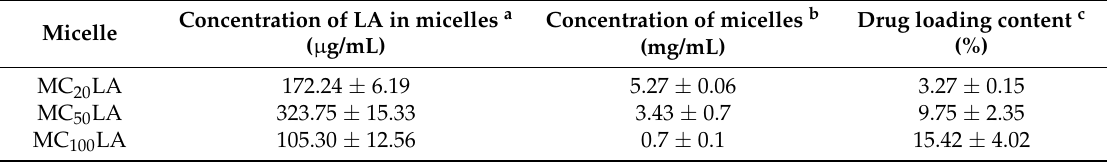
Table 4. Concentration of LA loaded micelles and drug loading content.